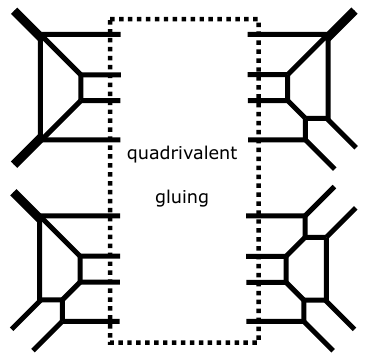
Figure 26. (a): The web diagram for g (1)